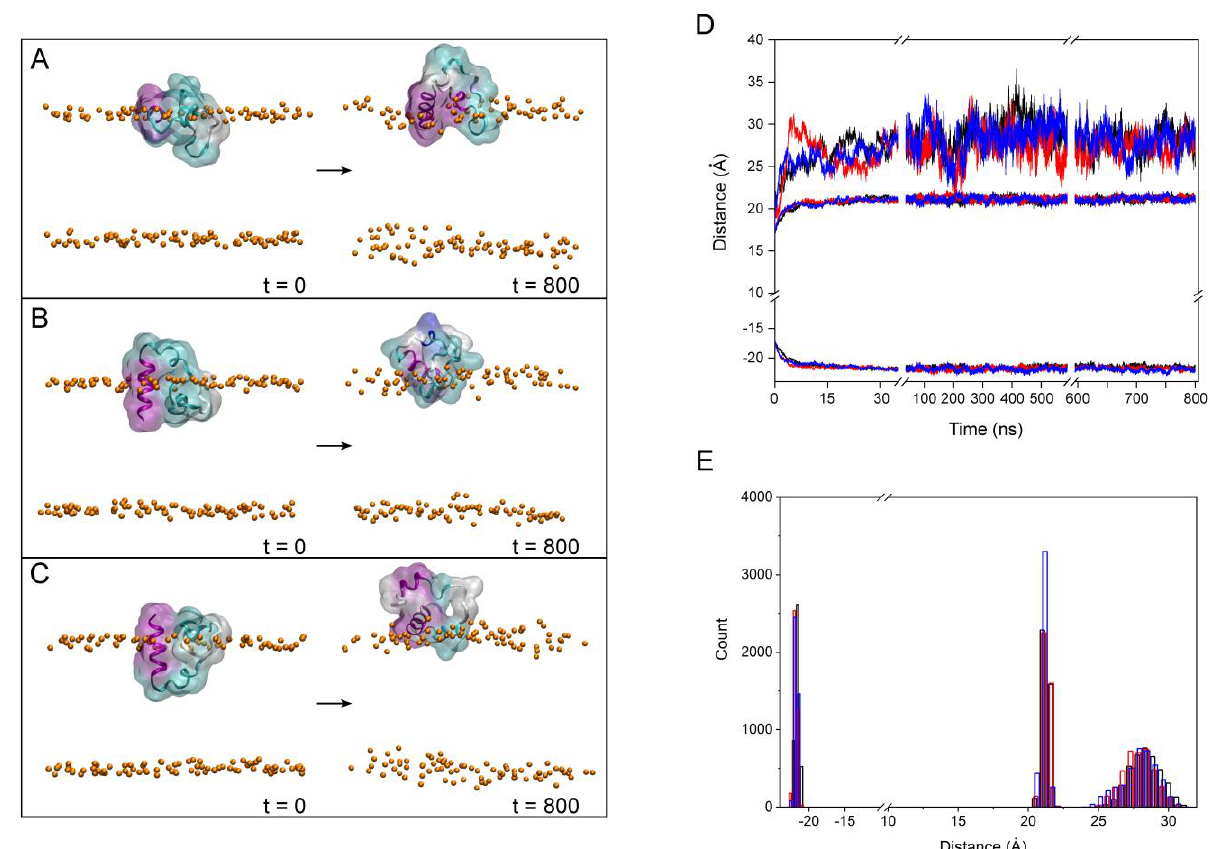
Figure 4. Initial (t = 0 ns) and final (t = 800 ns) arrangements corresponding to the third step, i.e., model membrane similar to the late endosomal one, for ( A ) system 3-1, ( B ) system 3-2 and ( C ) system 3-3 in the presence of 0.15 M NaCl (MD time 800 ns). The peptides are shown in both ribbon and surface transparent drawing style with coloured secondary structures (white (coil), violet (helix), yellow (extended), light blue (turns)). The phospholipid phosphate atoms are shown in VDW drawing style (orange) and the water molecules. The chloride and sodium ions have been removed for clarity. ( D ) Time variation of the z -axis distance (centre of the membrane as reference) and ( E ) distance histograms of the FP peptide and the phosphate atoms of the phospholipids (systems 3-1 (black), 3-2 (red) and 3-3 (blue), last 30 ns of the MD simulation).